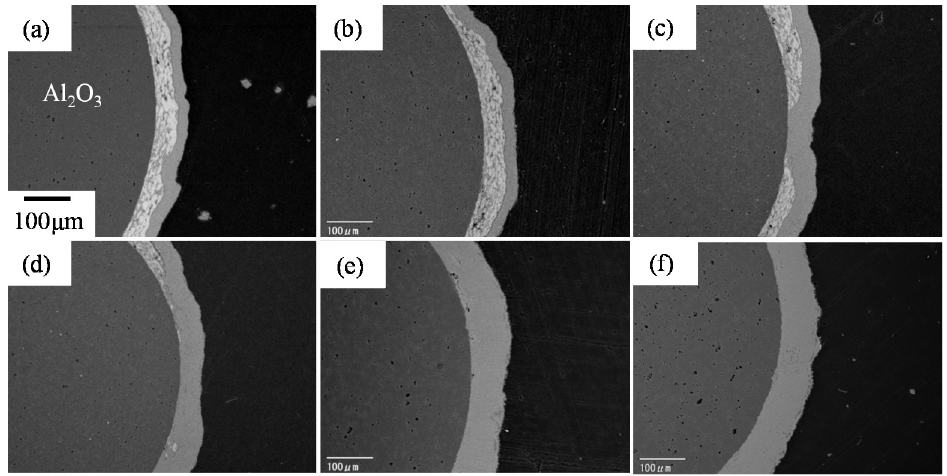
Figure 36. Cross-section SEM images of M10-1073 K- y h samples. ( a ) 10 h, ( b ) 15 h,